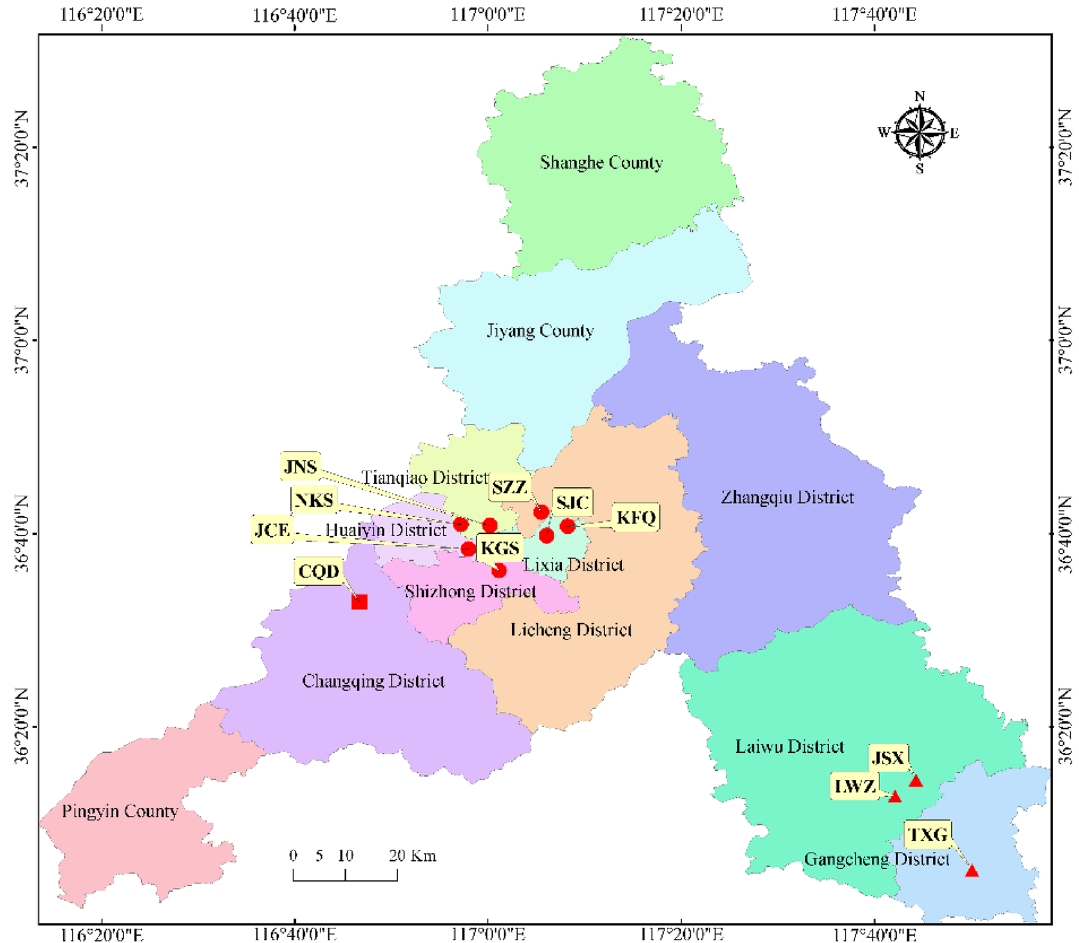
Figure 1. Spatial distributions of the different observation sites and industrial enterprises above a designated size threshold in Ji’nan city. JCE, machine tool factory No. 2; LSX, technical college; JNS, Ji’nan fourth building group; KFQ, economic development zone; KGS, Kegansuo; LWZ, Laiwu memorial hall; NKS, Agricultural Scientific Institute; SZZ, Seed warehouse of Shandong Province; SJC, Ji’nan monitoring station; TXG, Taixing company; CQD, Changqing school. Red circles, red triangles and red squares represent stations in urban, urban- industrial and suburban regions, respectively. The map of Observation site was completed by the geostatistical analysis module of ArcGIS (version 10.3, https:// devel opers. arcgis.